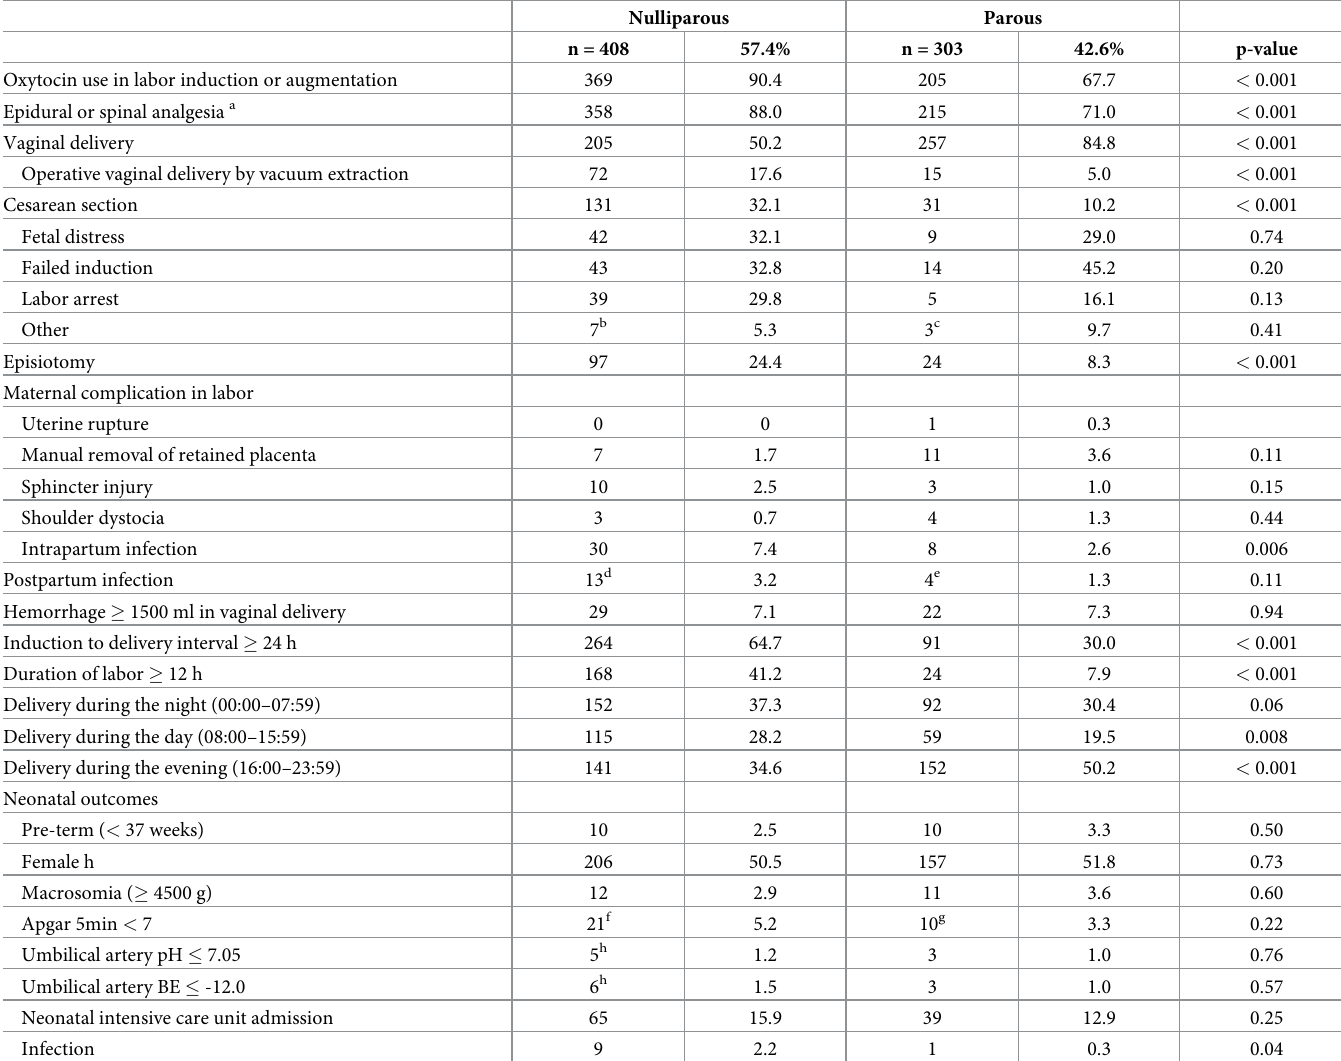
Table 2. Delivery and neonatal outcomes (N =